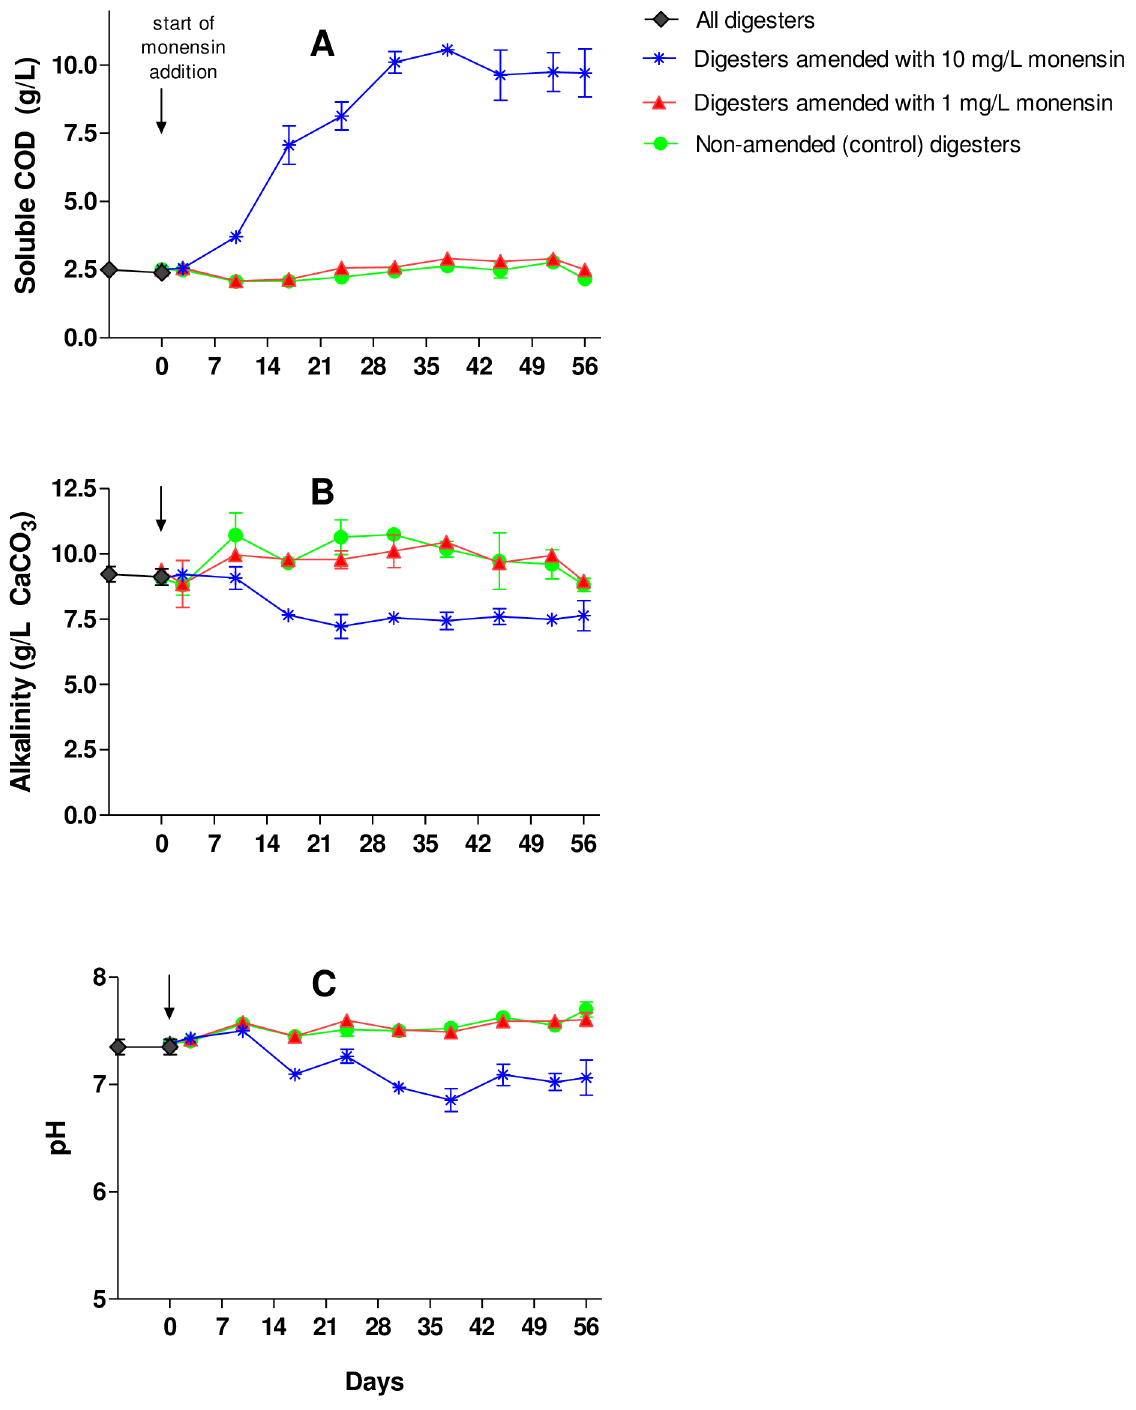
Fig 3. Effluent soluble COD concentrations (g/L) (a); effluent alkalinity, (g/L as CaCO 3 ) (b); and effluent pH (c) from the field-scale (FS) digesters operated using dairy manure (non-amended) and dairy manure amended with monensin to 1 and 10 mg/L. Values are the means from duplicate digesters. Standard deviations are shown as error